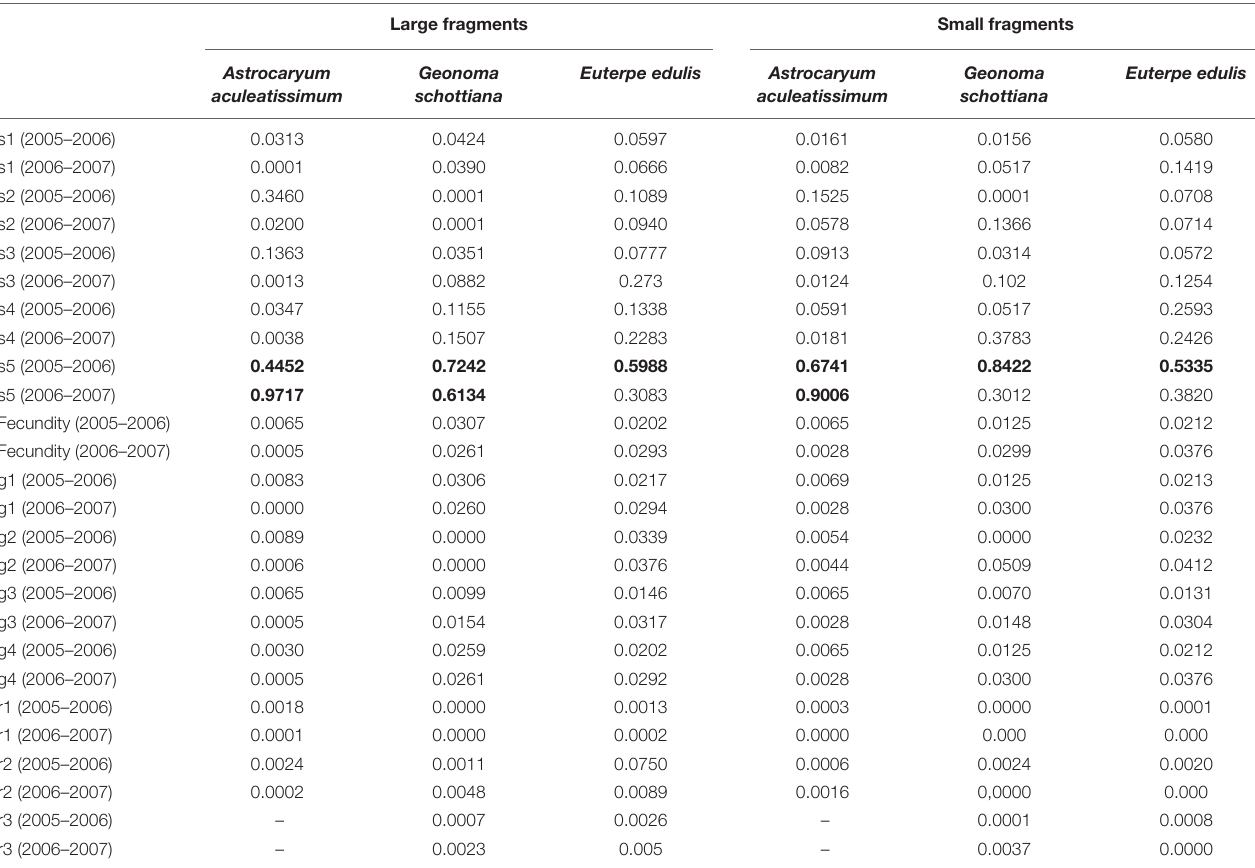
TABLE 4 | Elasticity of lower-level vital rates for Astrocaryum aculeatissimum , Euterpe edulis , and Geonoma schottiana in three small and two large forest fragments in the Atlantic Rain Forest. Large